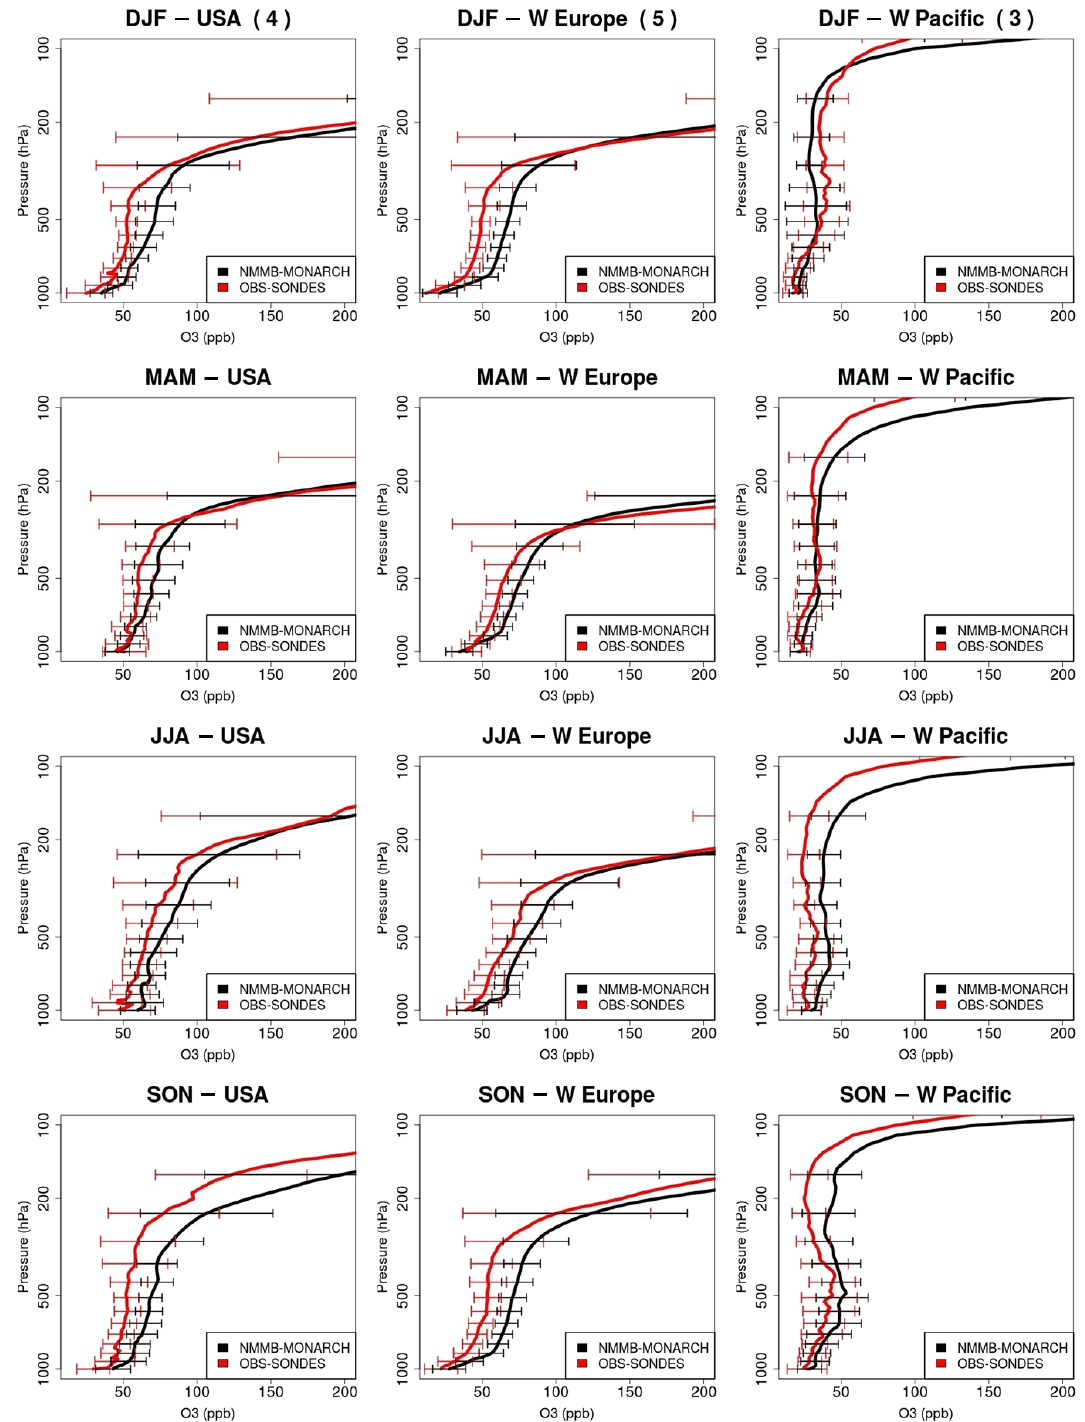
Figure 13. Comparison of ozonesonde measurements (red lines) and simulated (black lines) seasonal vertical profiles of O 3 (ppb) and standard deviations (horizontal lines). The region name and the number of stations are given above each plot between